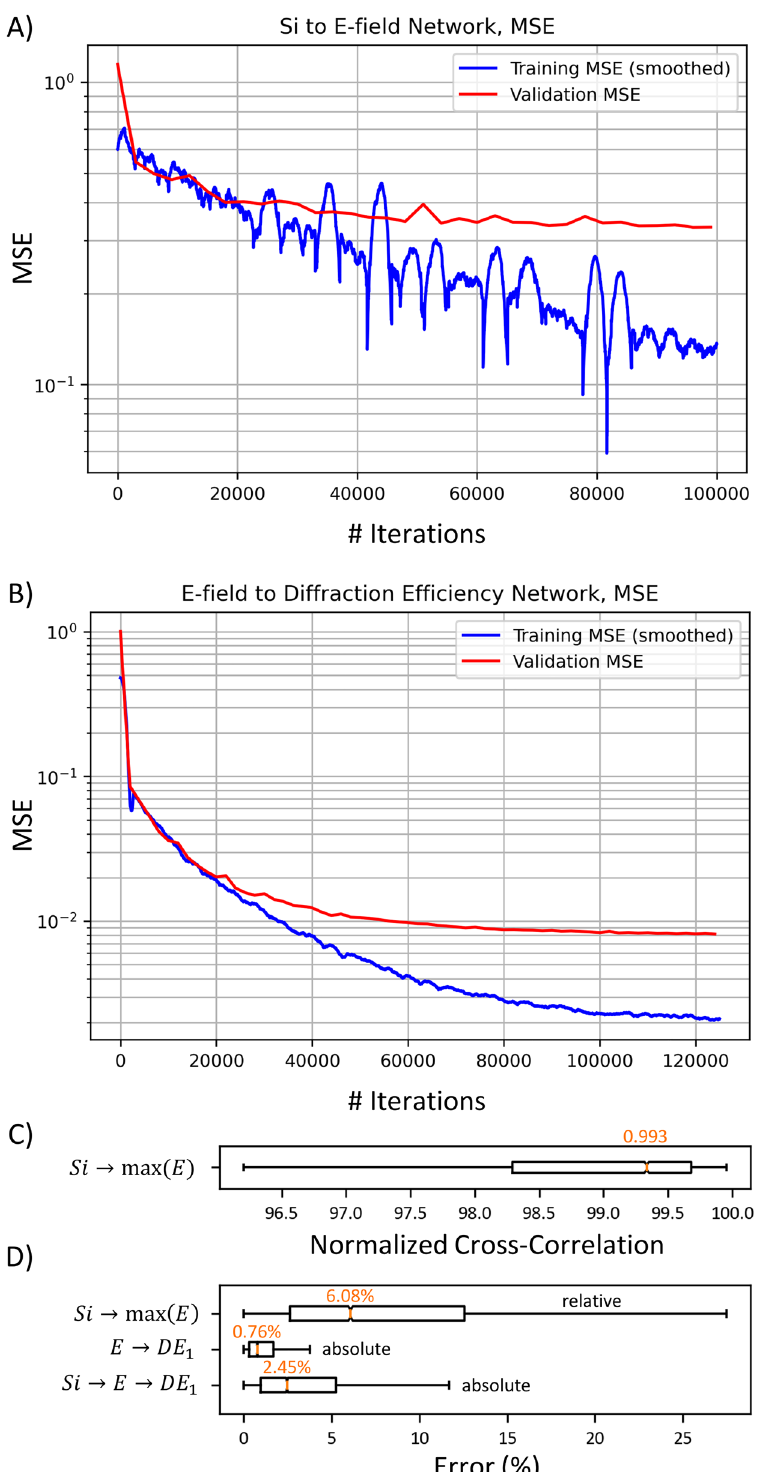
Figure 3: MSE curves show the training of both halves of the network. (A) Si to E-field U-Net training convergence curves. (B) E-field to diffraction efficiency CNN training convergence curves. MSE for